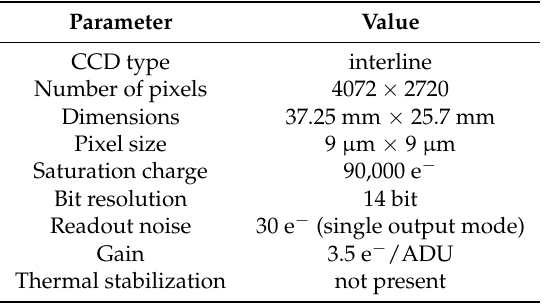
Table 1. Characteristics of CCDs installed in BRITE nanosatellites.